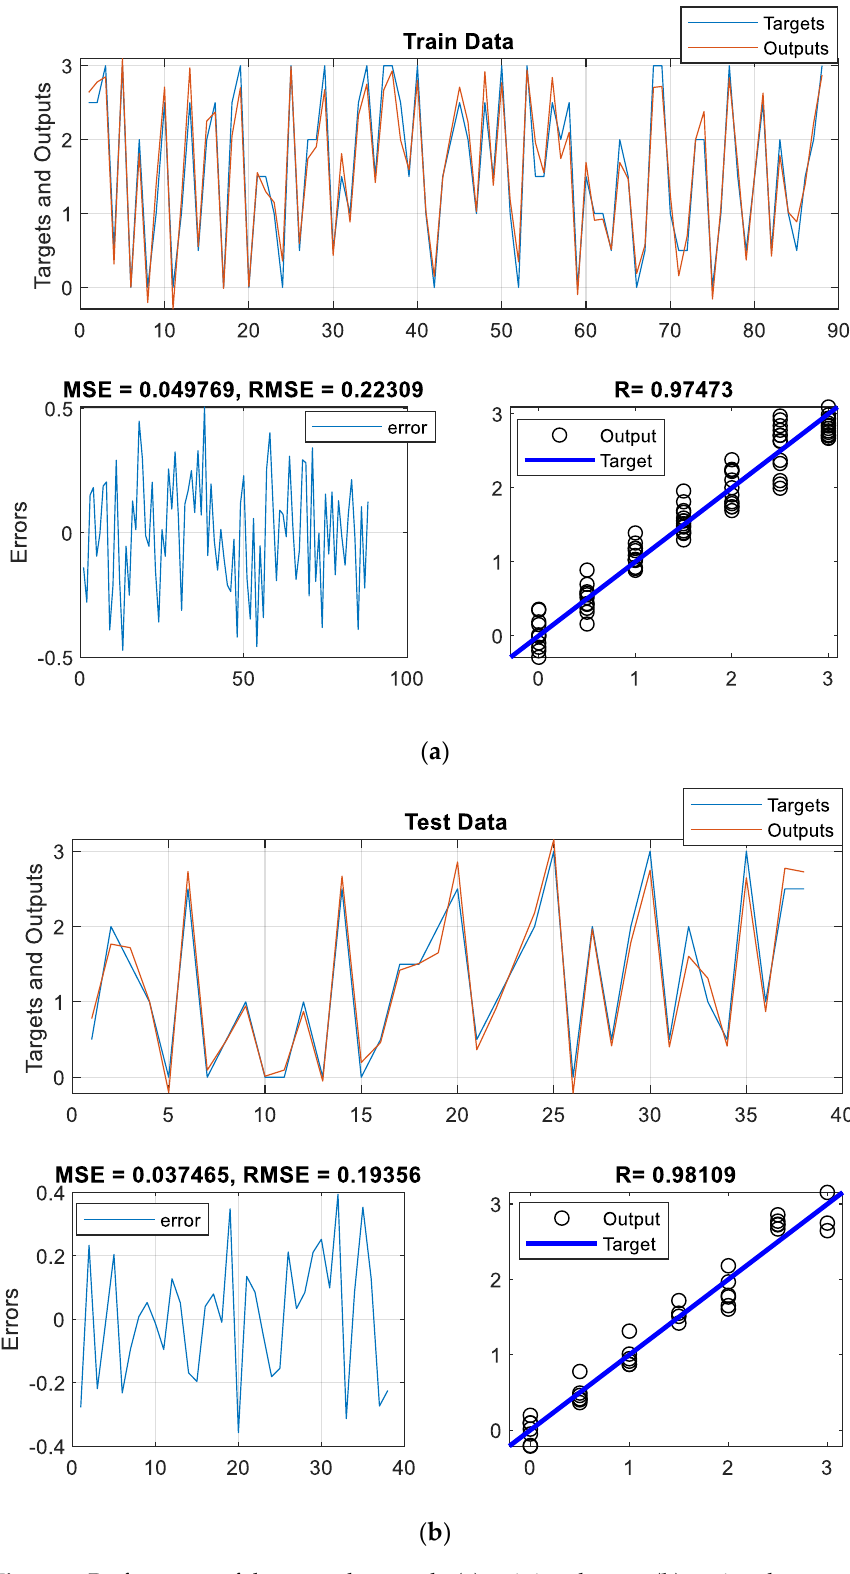
Figure 6. Performance of the neutral network: ( a ) training dataset, ( b ) testing dataset.